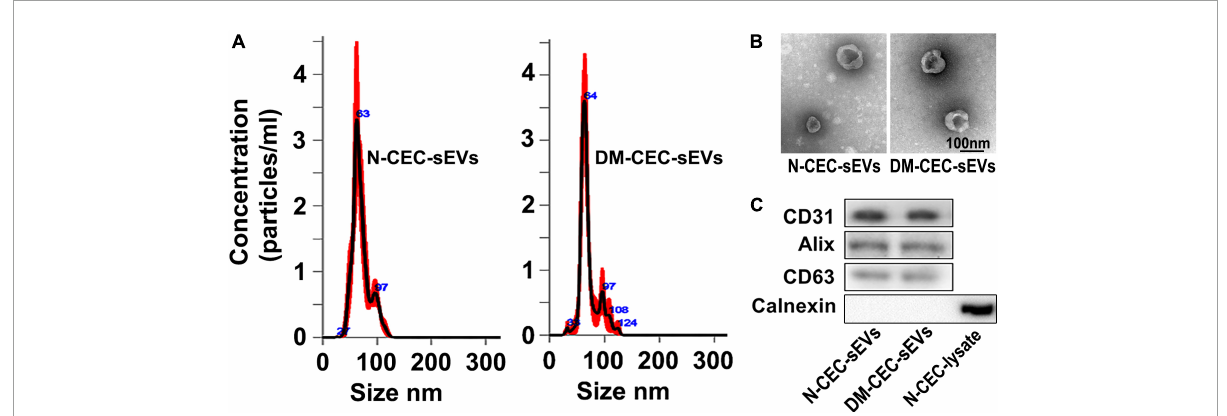
FIGURE1 Characterization of CEC-sEVs. NTA (A) shows size and distribution of N-CEC-sEVs and DM-CEC-sEVs. TEM image (B) shows the cup-shaped structures of N-CEC-sEVs and DM-CEC-sEVs. Western blot images (C) show sEV membrane protein markers, but not intracellular protein calnexin.